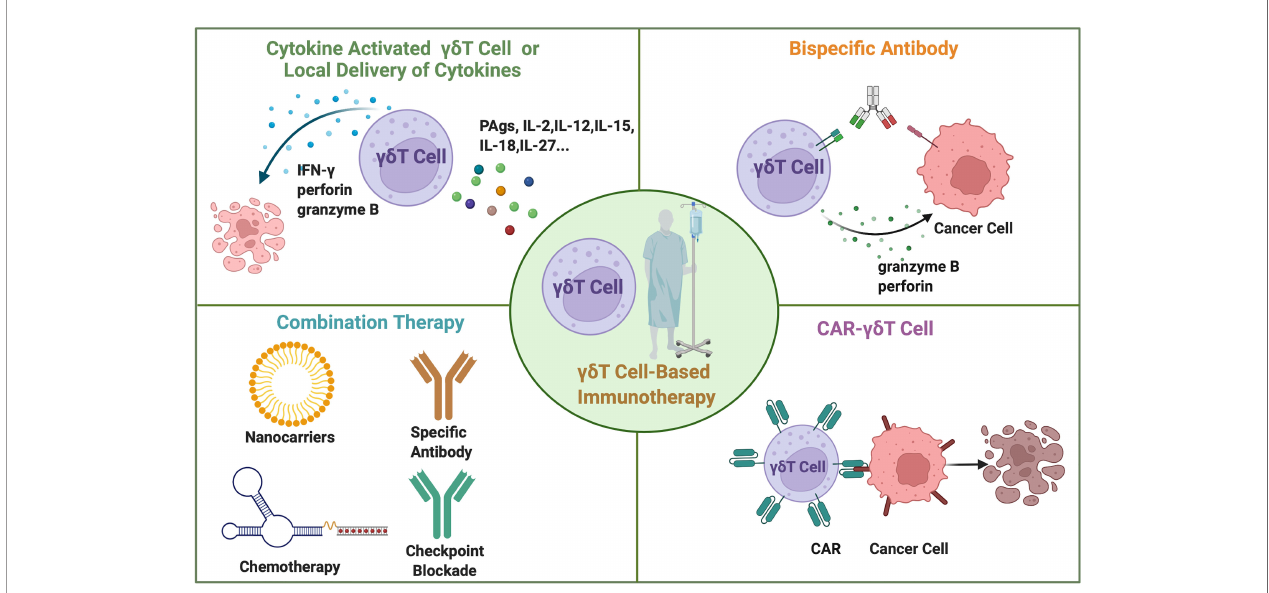
FIGURE 4 | The current approaches for gd T cell-based cancer immunotherapy. The adoptive transfer of cytokine-activated gd T cells in vitro or locally administration of cytokines in vivo . Combination therapy includes gd T cell transfer combined with speci fi c antibody therapy, immune checkpoint blockade, chemotherapy, and nanoparticles. Bispeci fi c antibodies simultaneously bind to gd T cells and cancer cells. Gene modi fi ed CAR- gd T cells directly recognize the cancer cells and mediate cancer cell